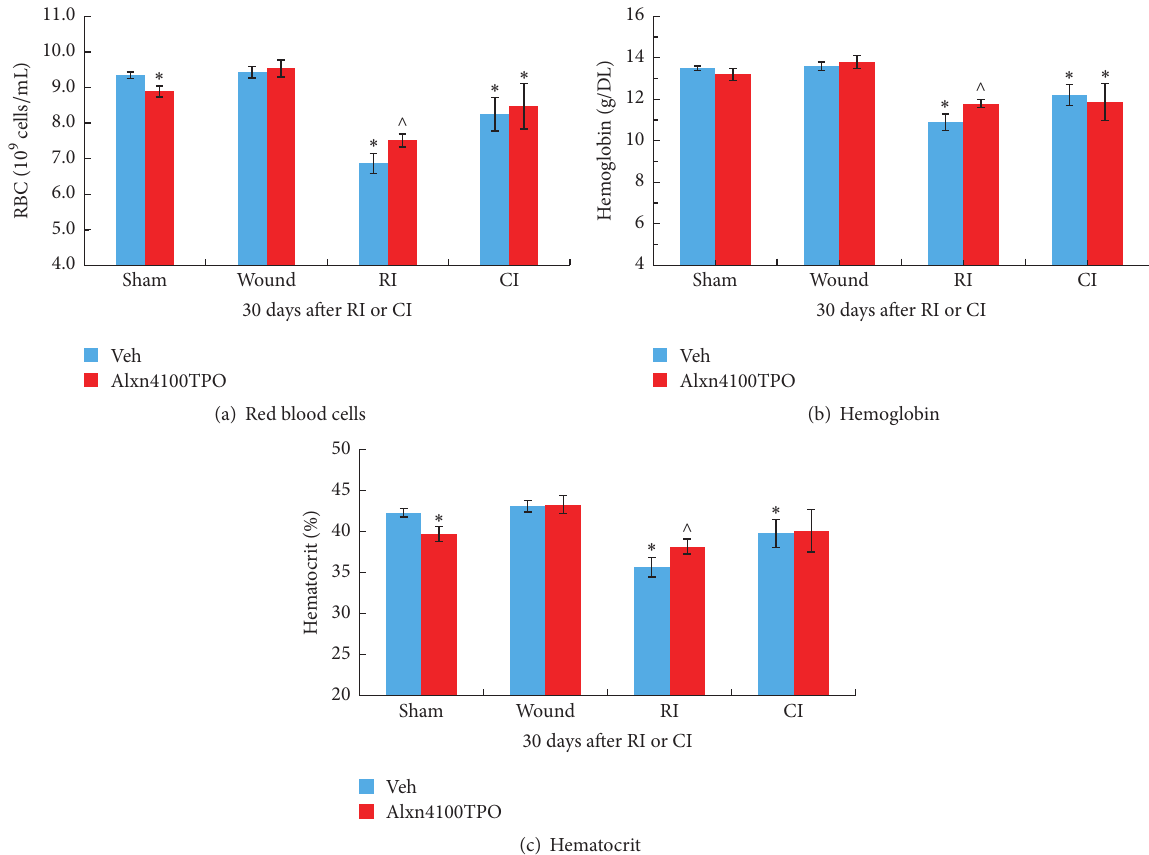
Figure 4: RI and CI decreased RBC counts, hemoglobin concentrations, and hematocrit values but Alxn4100TPO significantly mitigated only the RI-induced decreases. RBC counts, hemoglobin concentrations, and hematocrit values in blood samples collected 30 days after RI and CI were measured. 𝑁 = 6 per group. Data are presented as mean ± SEM. ∗ 𝑝 < 0.05 versus Vehicle Sham; ∧ 𝑝 < 0.05 versus Vehicle RI. RI: 9.5 Gy; CI: 9.5 Gy and skin